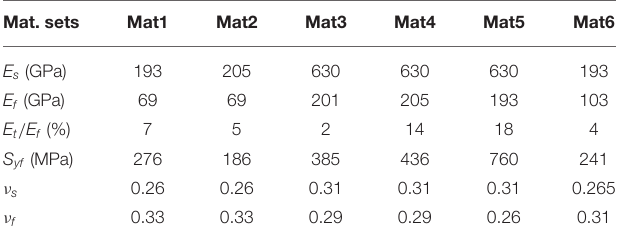
TABLE 1 | Material sets used in the comparisons. Mat. sets